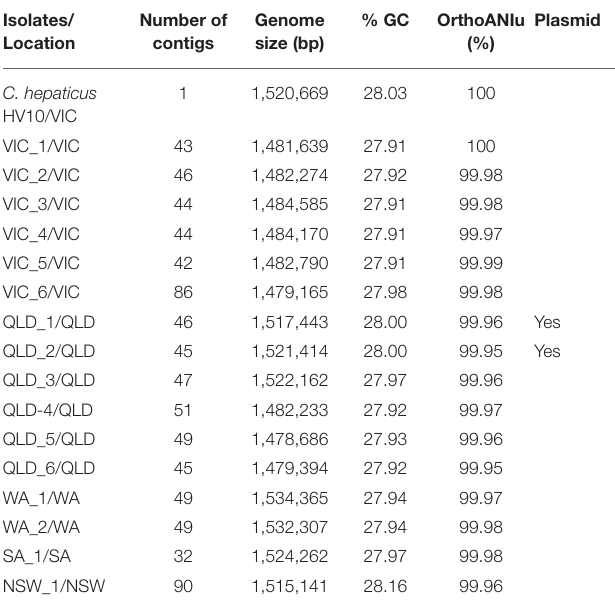
TABLE 3 | The similarity of new C. hepaticus isolates compared to C. hepaticus type strain,